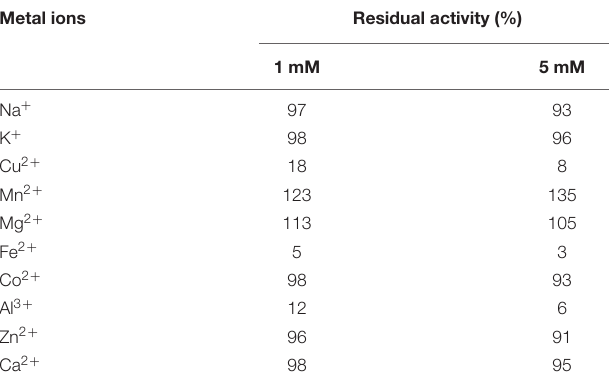
TABLE 3 | Effects of different metal cations on Sh Csn46 stability.